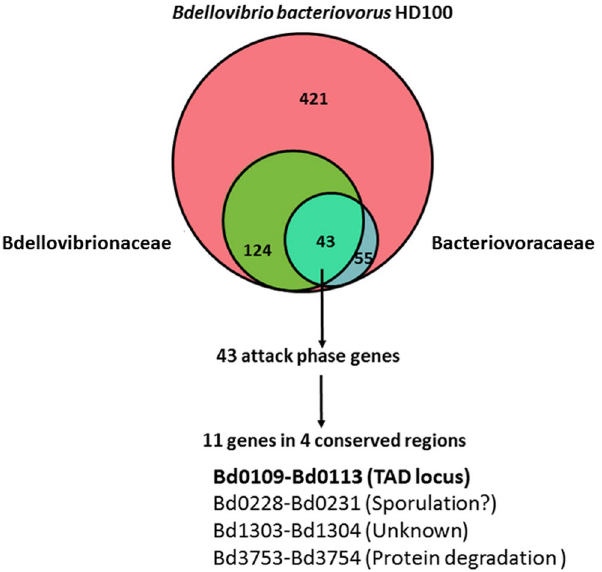
Figure 1. Overlap of attack phase genes between strains of Bdellovibrio and like organisms, identifying putative predation-essential genes. 124 Bdellovibrionaceae and 55 Bacteriovoracaceae genes exhibit high similarity (BSR ≥ 0.2) to 421 B. bacteriovorus HD100 AP-induced genes. The overlap of the three sets depicts 43 AP core genes, 11 of which cluster in four B. bacteriovorus HD100 genomic regions. Each of these regions is a putative operon as indicated by RNAseq expression data (BdelloViewer, http://www.weizmann.ac.il/molgen/Sorek/ bdello_browser/viewer/index.php?meta=bdello_combined&jump=bdello,bdello_sRNAs#1 23 . The Venn diagram was created using Biovenn 69